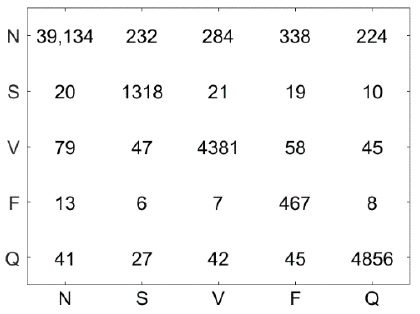
Figure 10. Confusion matrix using the LSVM model.